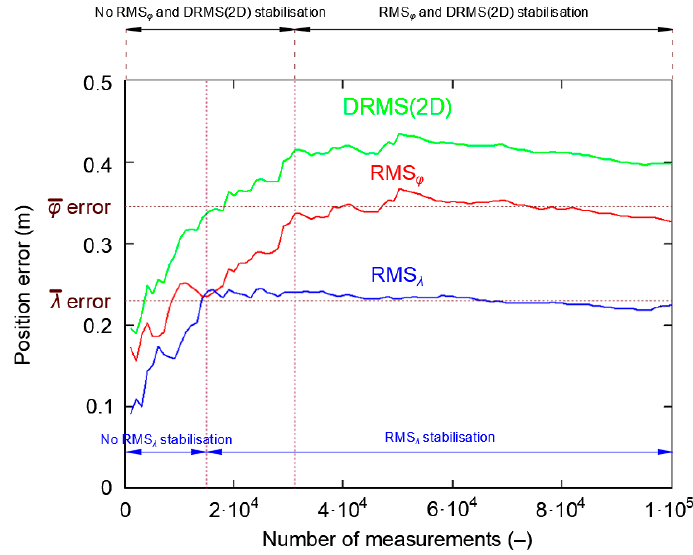
Figure 14. The process of stabilizing RMS values for φ and λ , as well as DRMS(2D) for the first 100’000 fixes during the DGPS measurement campaign in 2014.